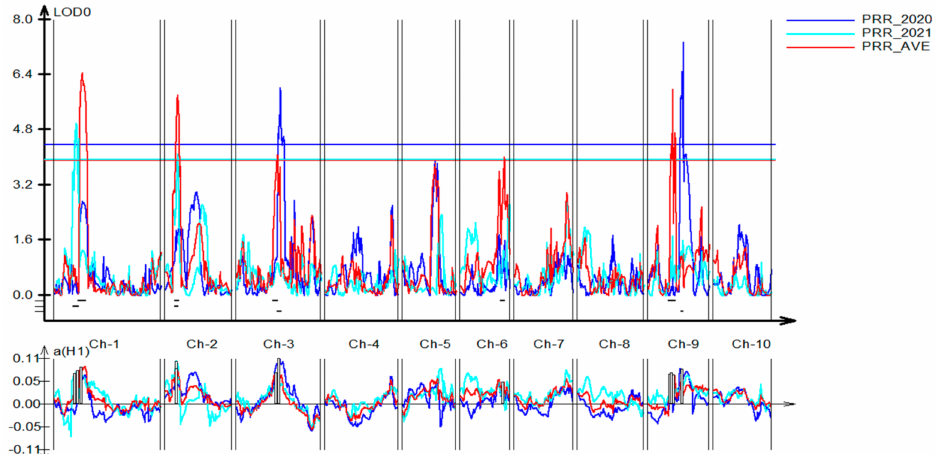
Figure 4. Detection of quantitative trait loci (QTLs) for the PRR in the segregating population. The log of odds (LOD) and additive effect, a(H1), plotted against the ten chromosomes were used for linkage analysis. The horizontal lines represent the threshold values for detecting authentic QTLs.